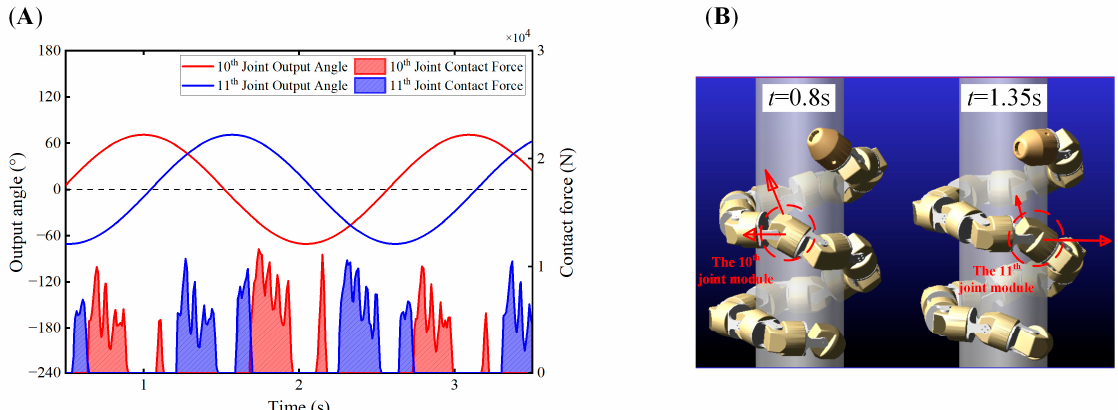
Figure 16. The output angle and contact force of two adjacent joints: ( A ) the output angle and contact force of joint modules; and ( B ) the contact force is applied to modules at different time points.